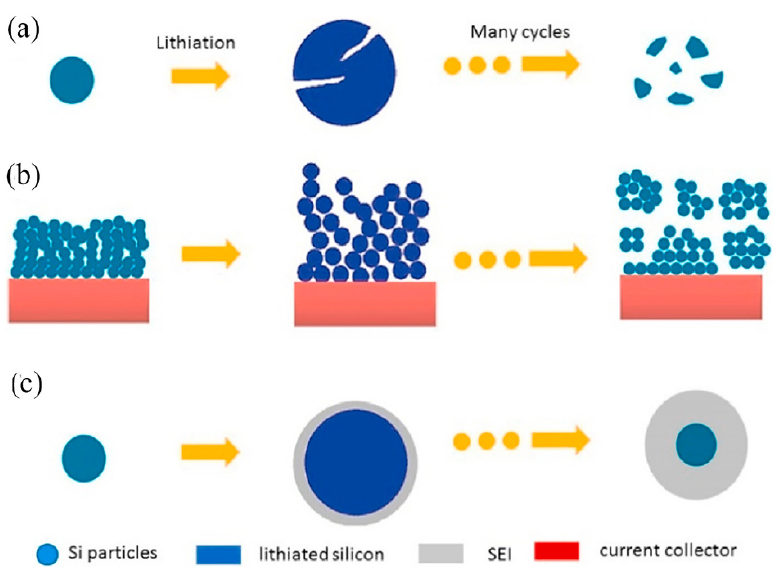
Figure 2. Various failure mechanisms of Si-based electrodes: ( a ) particle pulverization; ( b ) the repeated generation and destruction of SEI; ( c ) collapse of the electrode structure [76]. Reprinted with permission from Ref. [76]. Copyright 2021, J. Power Sources.